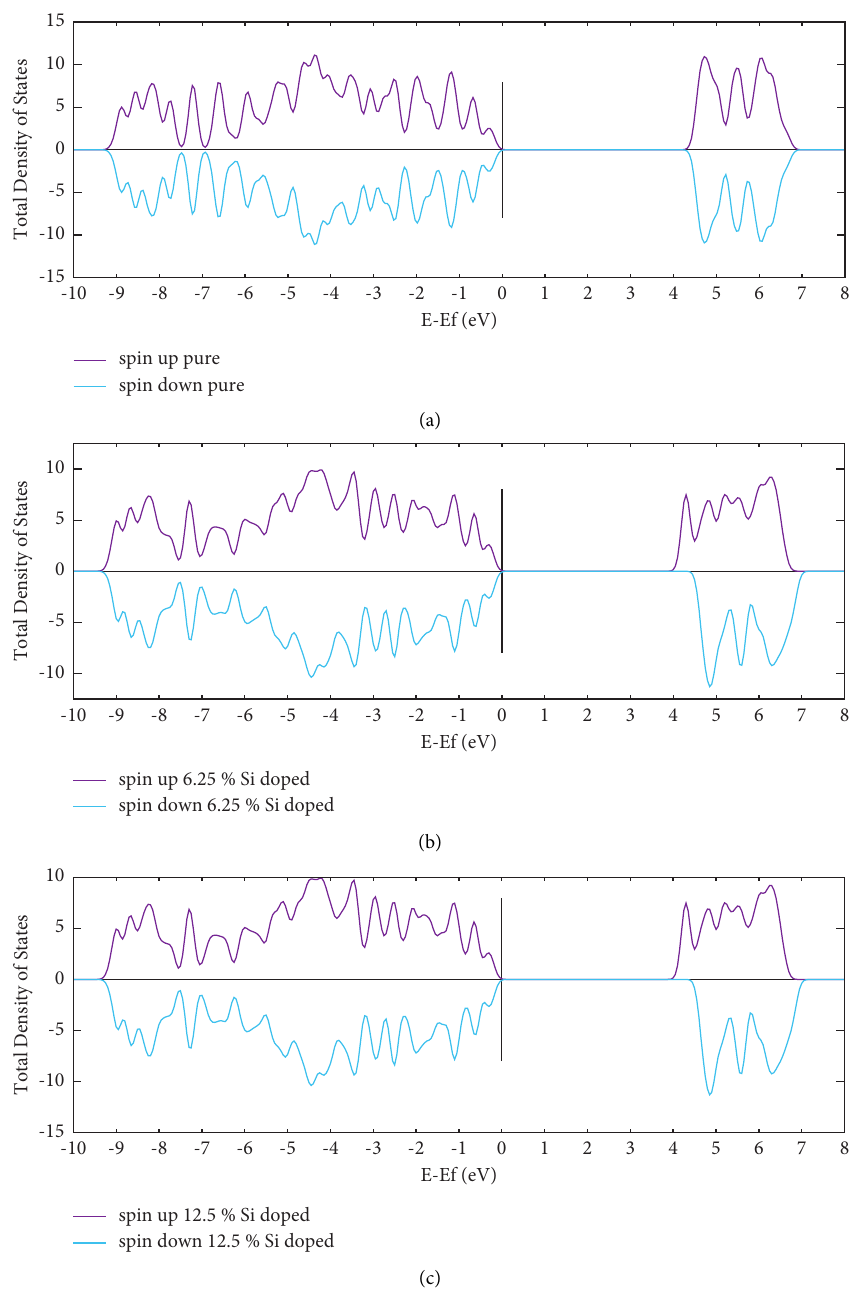
Figure 2: Calculated density of state for 4 × 4 × 1 monolayer BN. (a) Pure. (b) 6.25% of silicon-doped BN. (c) 12.5% of silicon-doped BN. The blue-violet and blue lines represent the spin-up and spin-down components, respectively. The zero-energy represents the Fermi